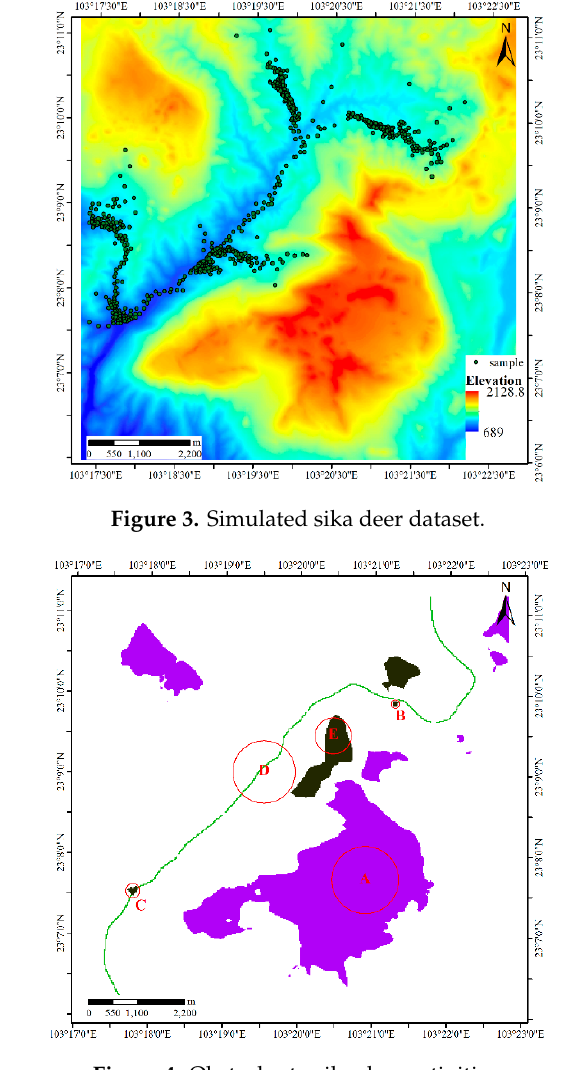
Figure 4. Obstacles to sika deer activities.